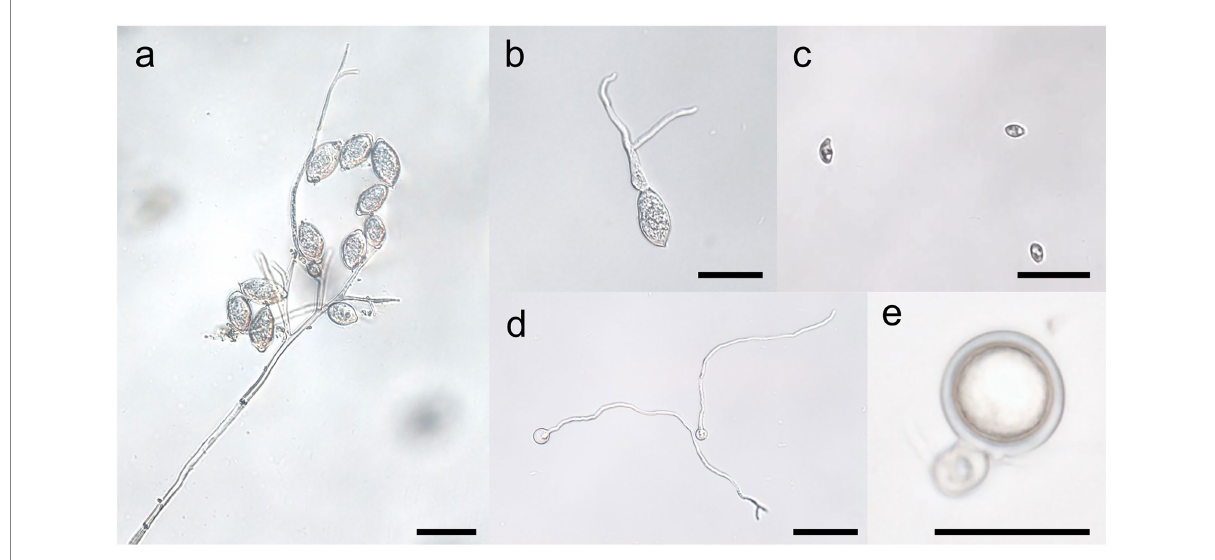
FIGURE 3 Stages of the spore cycles of Peronophythora litchii . A–E represent sporangiophore and sporangia, sporangium germination, zoospores, cysts germination, mature oospore, respectively. Bar represents 50 μ